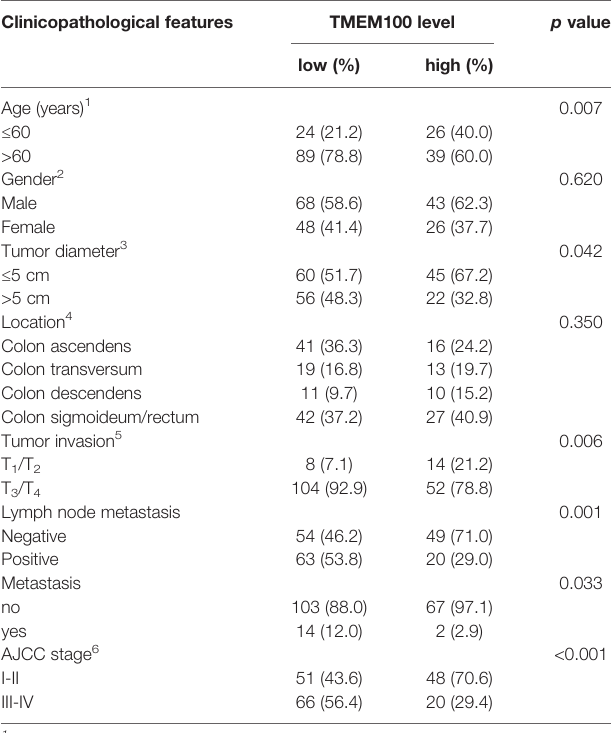
TABLE 1 | The association of TMEM100 expression with the clinicopathological characteristics of 186 CRC patients. Clinicopathological